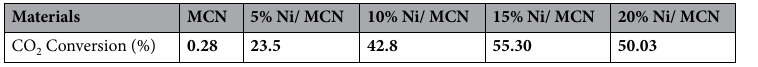
Table 3. Catalytic performance of Ni/MCN series at 450